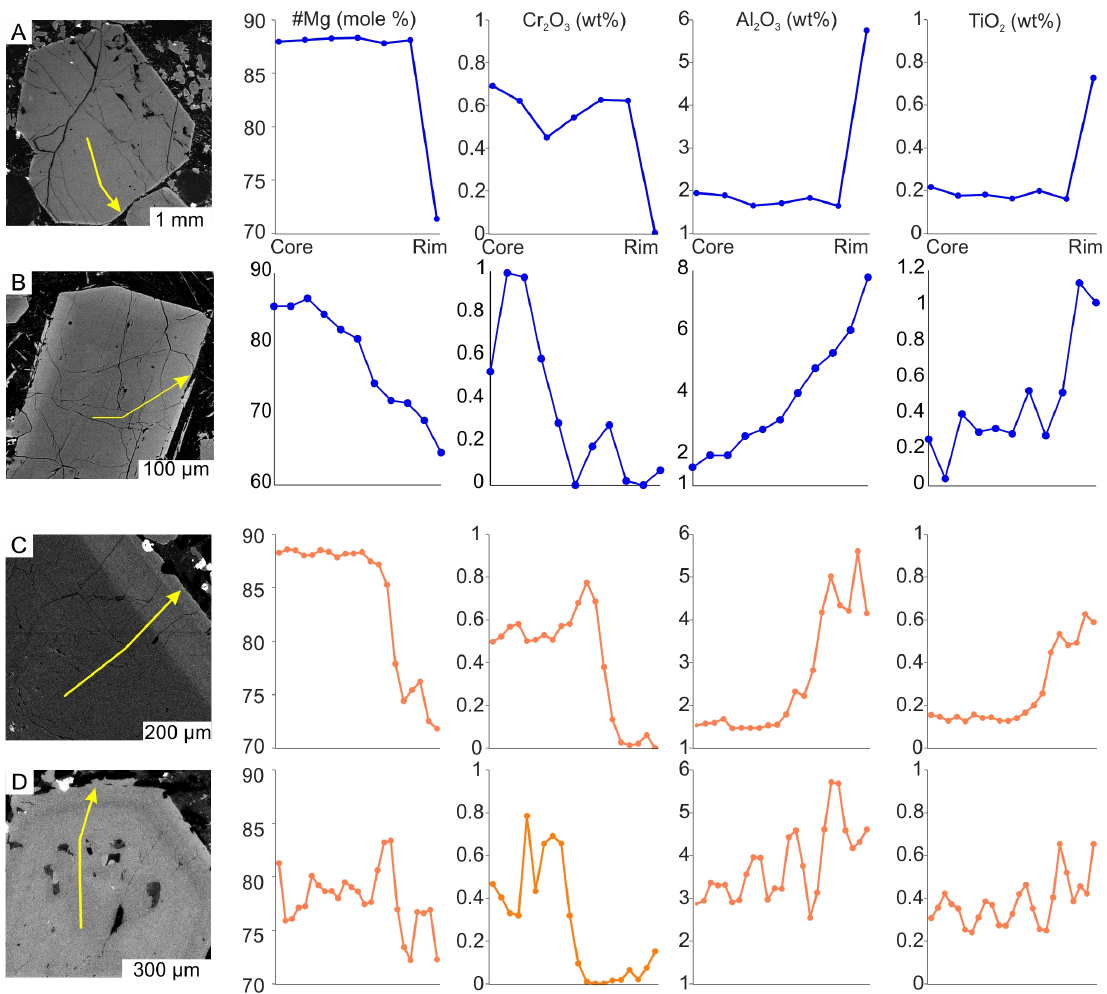
Figure 8. Chemical zoning of clinopyroxene grains. ( A ) Phenocryst, picrite; ( B ) groundmass grain, picrite; ( C ) basalt, two-zoned phenocryst; ( D ) basalt, phenocryst with oscillatory zoning. Images are BSE-photos, and yellow arrows outline core-to-rim microprobe profiles given to the right from the images.